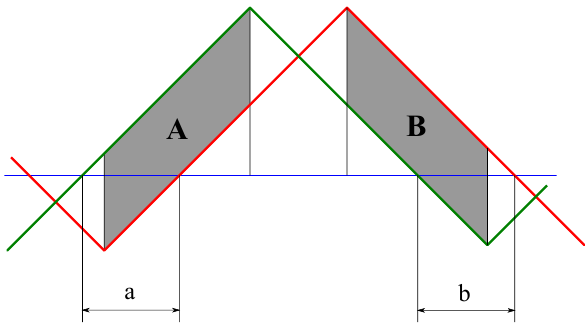
Figure 6. Tree model offset and attribute IS distances. The red and green lines refer to attribute IS distance for the two different Figure 5. A part of the tree models of Taiyuan City, Shanxi tree models, and the blue line refers to the zero distance Province, for January 2018 (a), 2019 (b), 2020 (c), and the reference. Offset a and b between the models is related to the integrated result (d). The horizontal and vertical axes correspond area A and B to two bands, respectively.